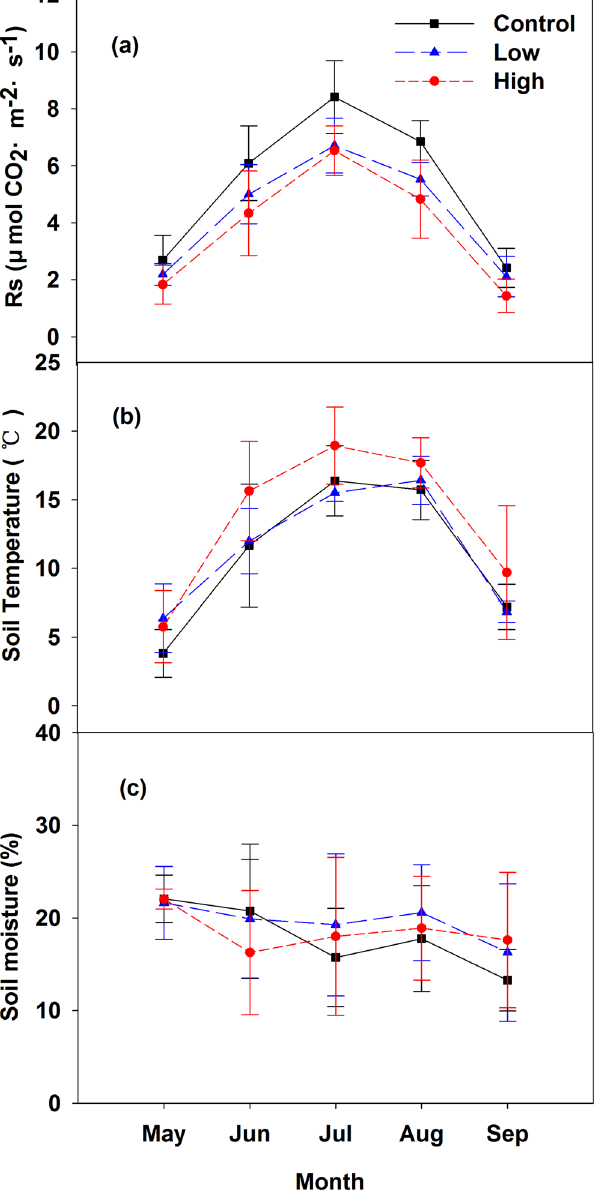
Figure 1. Seasonal variations of ( a ) the total soil respiration rates ( R s), ( b ) soil temperature and ( c ) soil moisture in the control, low, and high burning severity plots. The data were the average values in 2010, 2011, and 2012. The error bars represent the standard